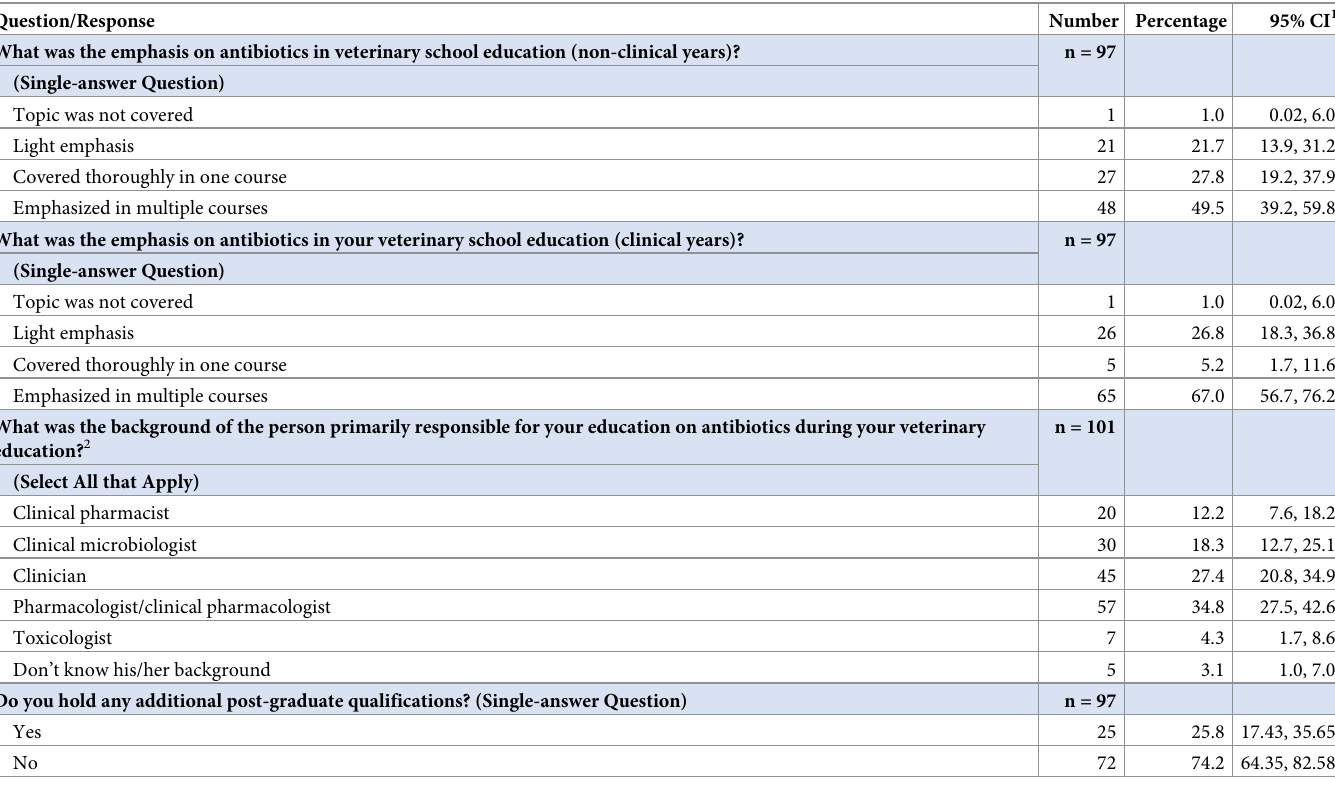
Table 2. Responses of veterinarians in Kentucky regarding their training on antibiotics, 2017.